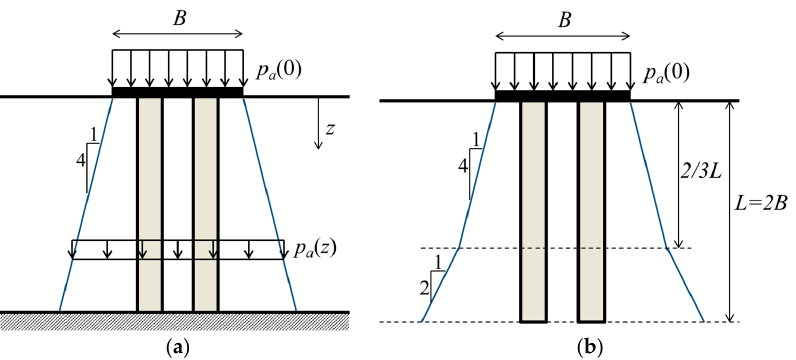
Figure 5. Stress distribution beneath footings: ( a ) End-bearing columns; ( b ) Floating columns.